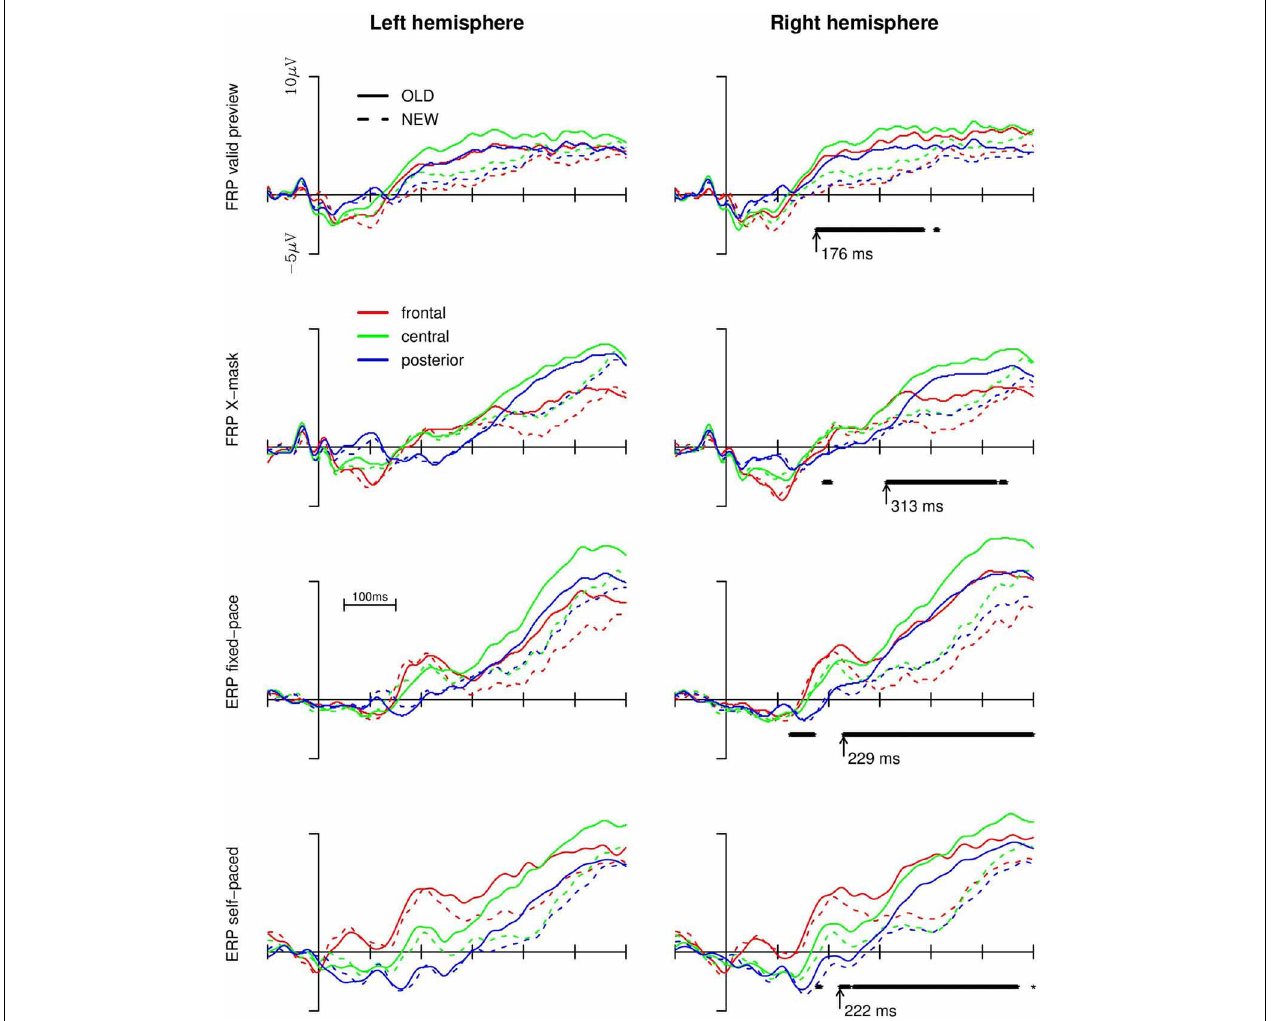
FIGURE 2 | Brain potentials (upper two rows: fixation-related; lower two rows: event-related) in the four experimental conditions for the left and right hemisphere and the old vs. new words. A continuously reliable main effect of old vs. new words or the interactions of the effect